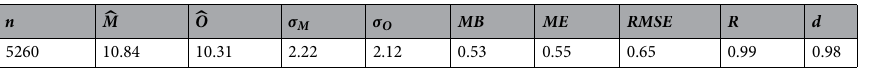
Table 1. Model skill metrics for bottom temperature. Column definitions are as follows: total number of (cid:31) O (cid:31) M ) observations ( n ), mean modelled temperature ( , mean observed temperature ( ), modelled standard deviation ( σ M ), observed standard deviation ( σ O ), Mean Bias ( MB ), Mean Error ( ME ), Root Mean Square Error ( RMSE ), Correlation Coefficient ( R ) and Index of Agreement ( d ). Units are °C except for n , R and d which are unitless.